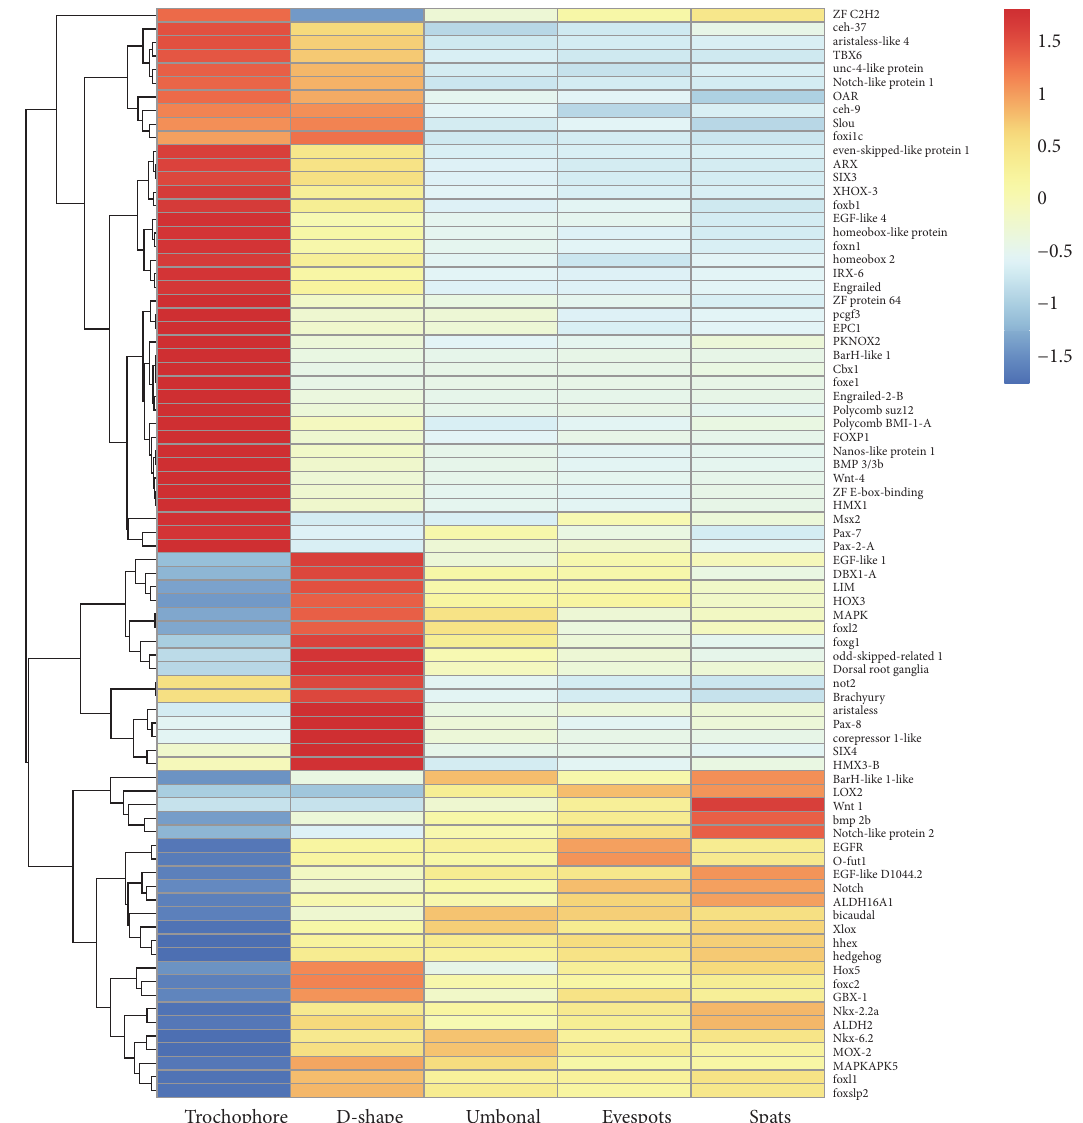
Figure 9: Clusters of expression patterns of development-related genes across five larval stages in Pinctada fucata .